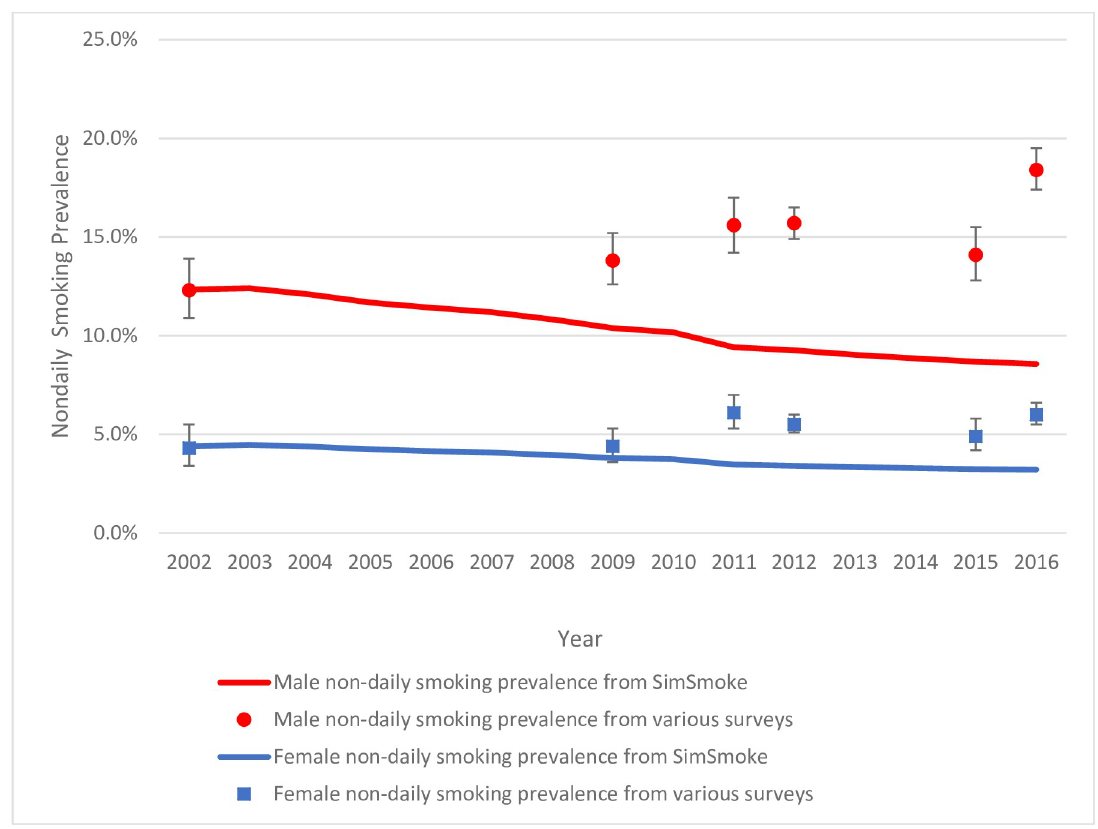
Fig 2. Validation of nondaily smoking prevalence, ages 15–65 by gender, from Mexico SimSmoke and various national surveys � , 2002–2016. � The survey point estimates (indicated by dots) and 95% confidence intervals were obtained from the National Addictions Survey (ENA) in 2002 and 2011, the Global Adult Tobacco Survey (GATS) in 2009 and 2015, the National Health and Nutrition Survey (ENSANUT) in 2012, and the National Survey of Drugs, Alcohol, and Tobacco Consumption (ENCODAT) in